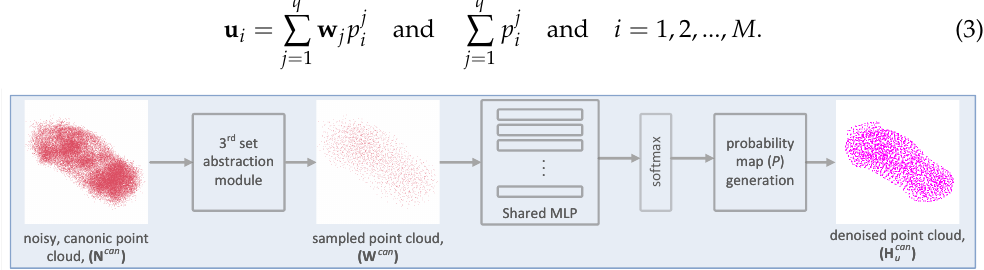
Figure 3. Denoising process of a noise-corrupted